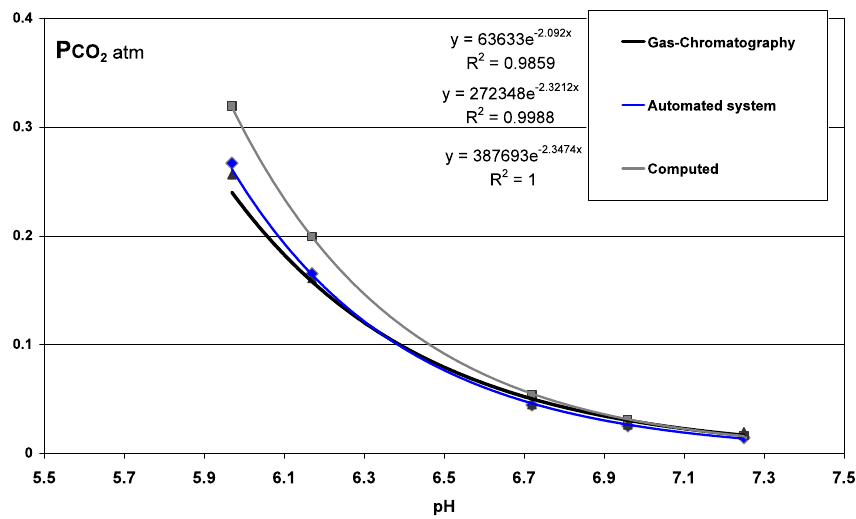
Figure 6. Comparisons between CO partial pressures and pHs obtained with the laboratory tests. The three curves represent the best fits of the P 2 both measured (using the automated system and gas chromatography analysis) and computed on the basis of the pH and the HCO values of P and pH were obtained by continually bubbling pure CO through natural water. The data highlight the good correlation between the CO2 2 and the reliability of the automated prototype different ways used for estimating the P CO2